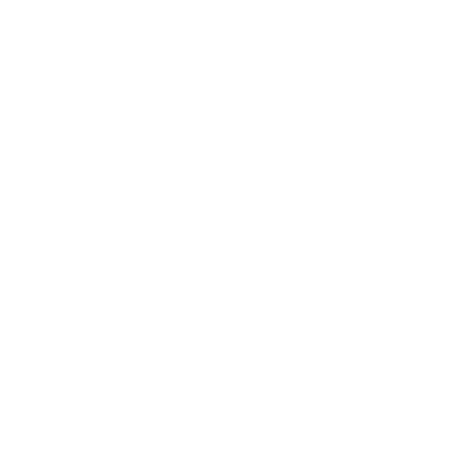
Figure 1. In the Angiosperm Phylogeny Group (APG) classification, erstwhile family Bombacaceae is allocated as subfamily Bombacoideae of the family Malvaceae. Cladogram of the Malvaceae is after Bayer et.al. 1999 and online version of APG (http://www.mobot.org/MOBOT/research/APweb; accessed on 10 January 2021). As a consequence of changes in circumscription and status of Bombacoideae, has led to the inclusion of 22 genera comprised of 120 species under this subfamily mainly dis- tributed in the tropical regions. The Angiosperm Phylogeny Group (APG) IV Classifica- tion listed 24 genera in this subfamily. However, the classification by Maarten et.al. listed 27 genera under Bombacoideae [9]. This classification includes genera like Camptostemon, Lagunaria, and Uladendron in the Bombacoideae sub family. Molecular phylogenetic anal- ysis established on nuclear (ETS, ITS) and plastid genes (matK, trnL-trnF, trnS-trnG) re- vealed that there are three key lineages noticeable by the kapok clade, seed, or fruit traits— the winged seed clade, and the spongy endocarp clade [4]. Such studies established the monophyly of the core Bombacoideae subfamily and the entire genera without Pachira . The monospecific Septotheca falls outside the core Bombacoideae in many studies [4,10].